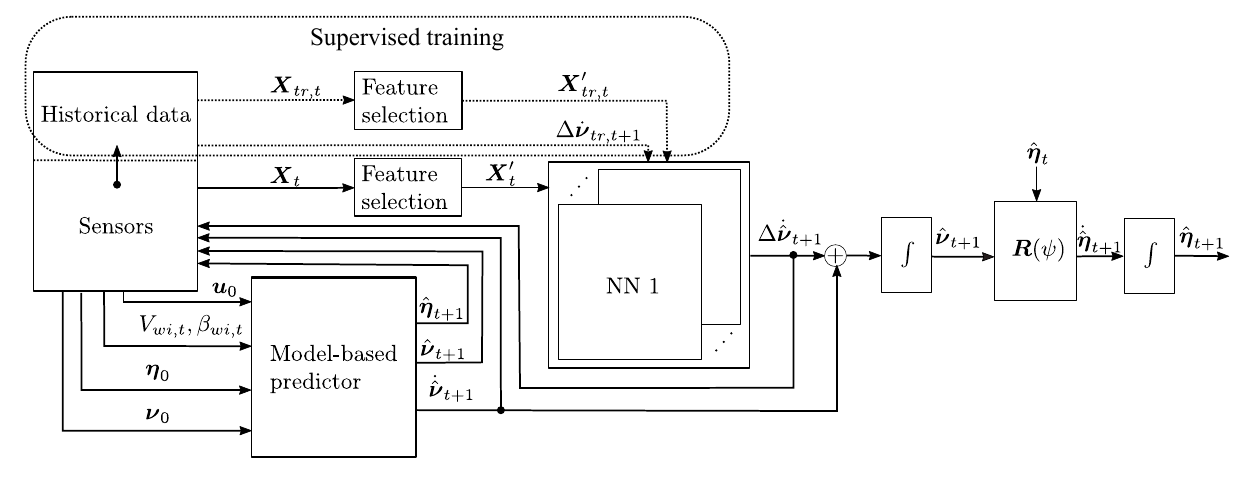
Figure 2: Hybrid predictor